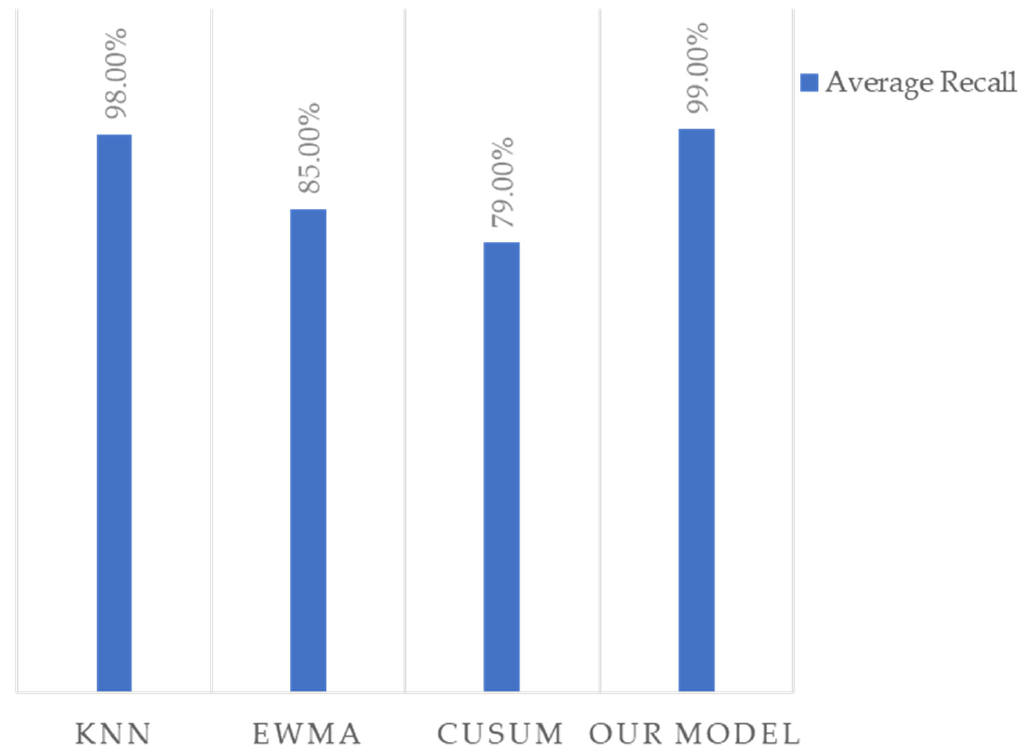
Figure A5. Comparison of the recall of EWMA, CUSUM, and KNN with our model.